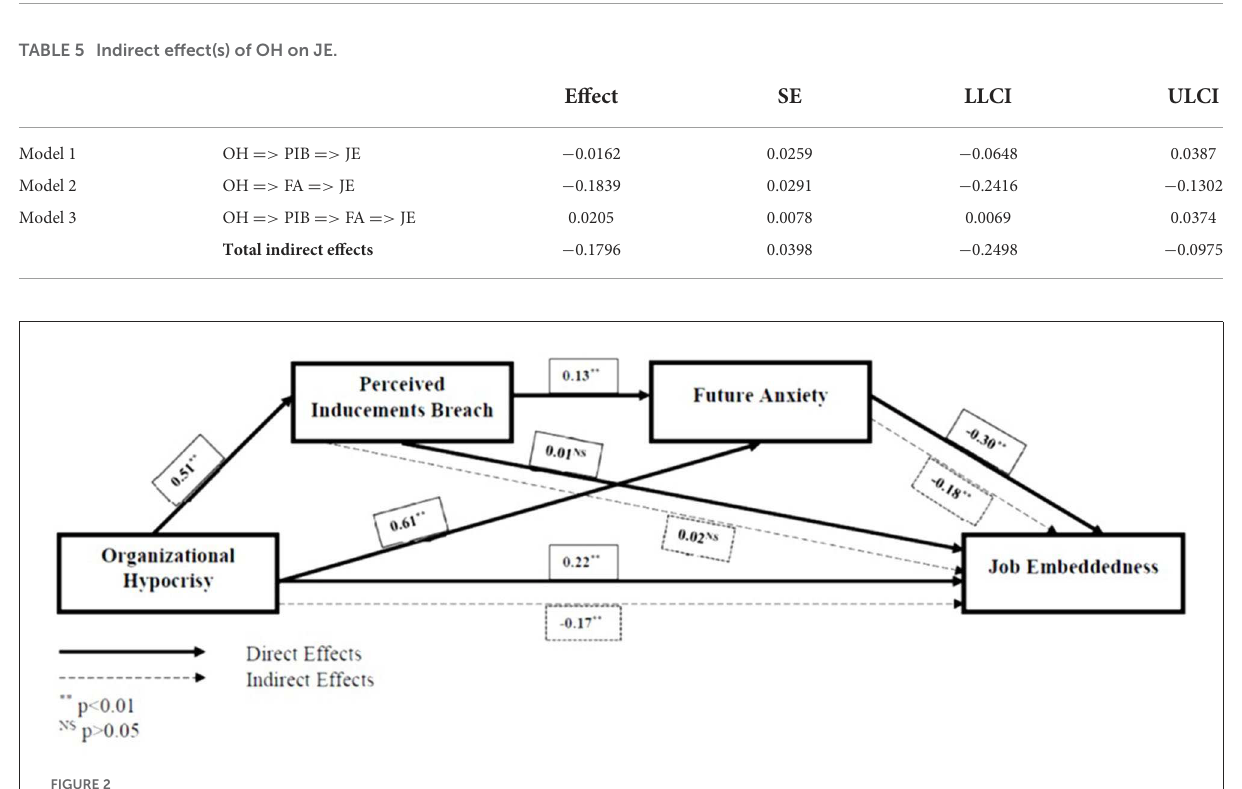
FIGURE2 Model of the study with effect